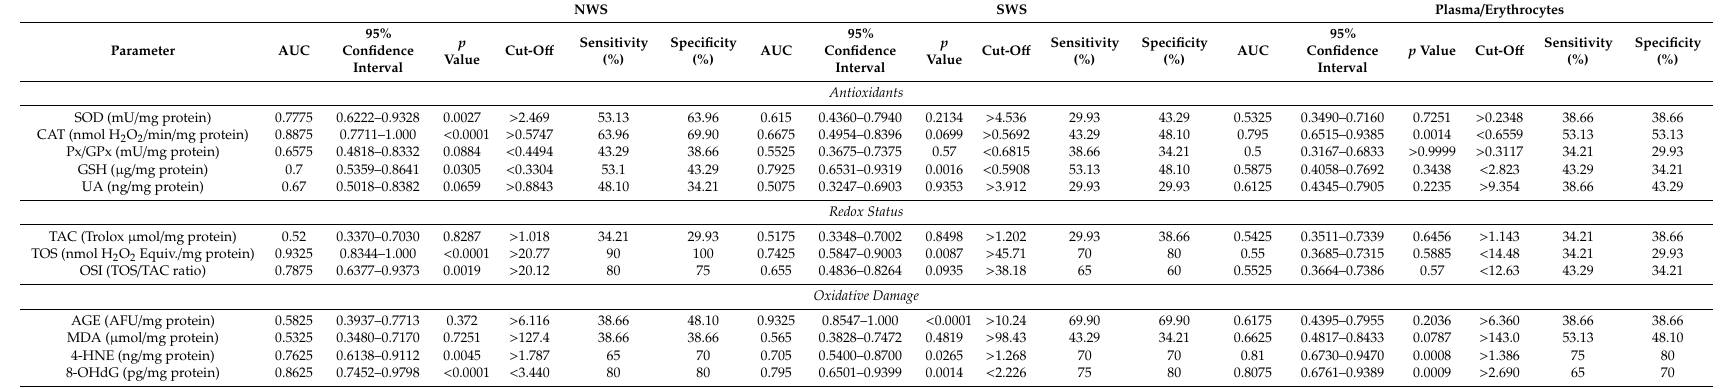
Table 3. Receiver operating characteristic (ROC) analysis to di ff erentiate between overweight and obese